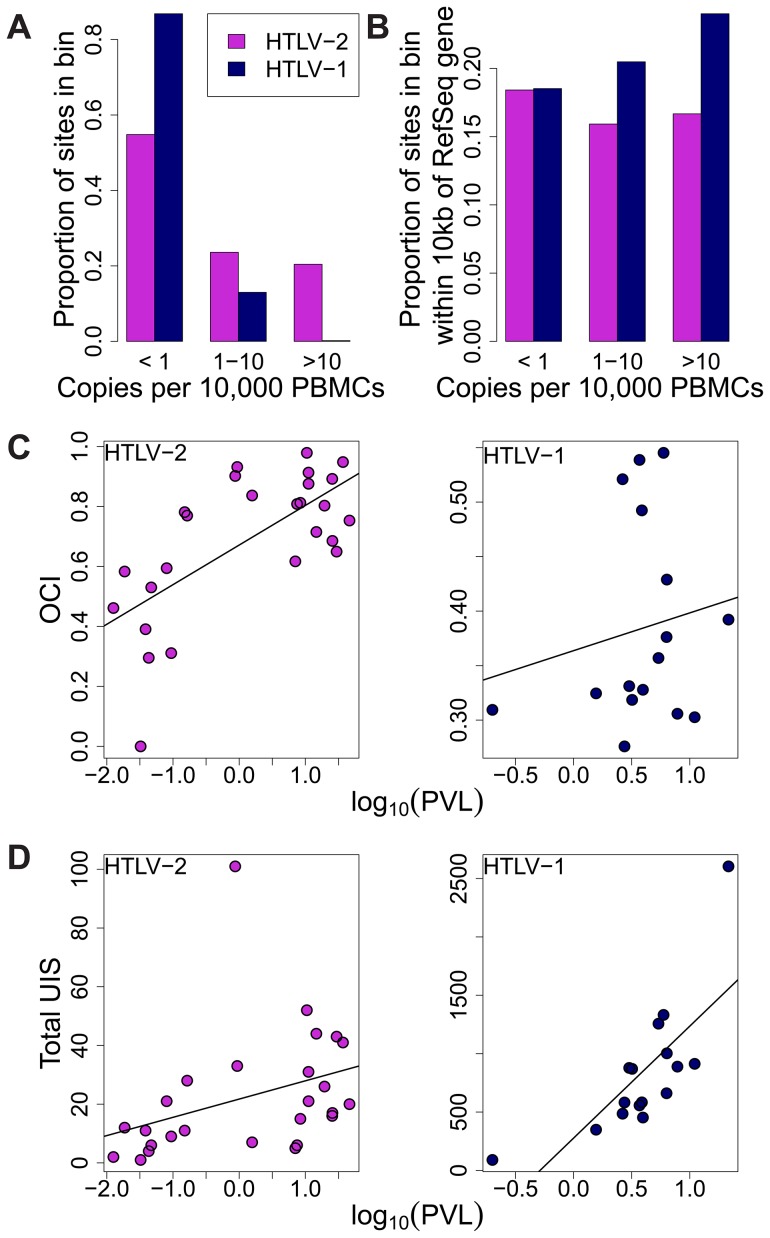
HTLV-2 integration site and clonal expansion.(A) The distribution of integration sites according to clonal abundance. Abundance was quantified by the number of copies estimated in a clone per 10,000 PBMCs (based on relative abundance and proviral load). Abundance bins are defined on a logarithmic scale. (B) The proportion of sites within 10 kb of a RefSeq gene for each abundance bin. A significant positive trend (p = 0.04, chi-squared test for trend) was detected for HTLV-1 but not for HTLV-2. (C) Oligoclonality index (OCI) versus log10(proviral load) for each virus. A strong positive correlation (p = 0.0015, Spearman's test) was detected between these parameters for HTLV-2 but not for HTLV-1(p = 0.681, Spearman's correlation). (D) The total number of unique integration sites (UIS) identified in each PBMC sample versus log10(proviral load) for each virus (p<0.001 for HTLV-1, p = 0.0019 for HTLV-2, Spearman's test).